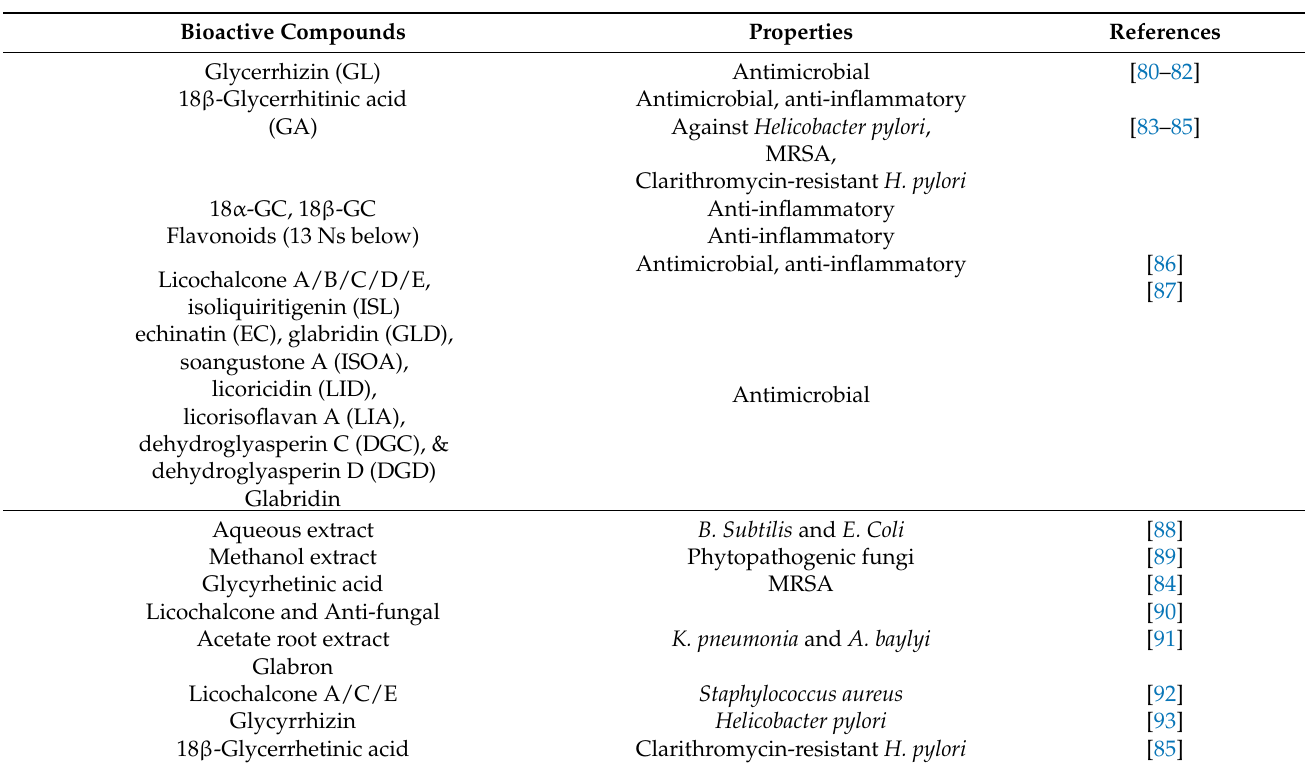
Table 1. A list of major bioactive compounds identified in licorice together with their therapeutical properties. Bioactive Compounds